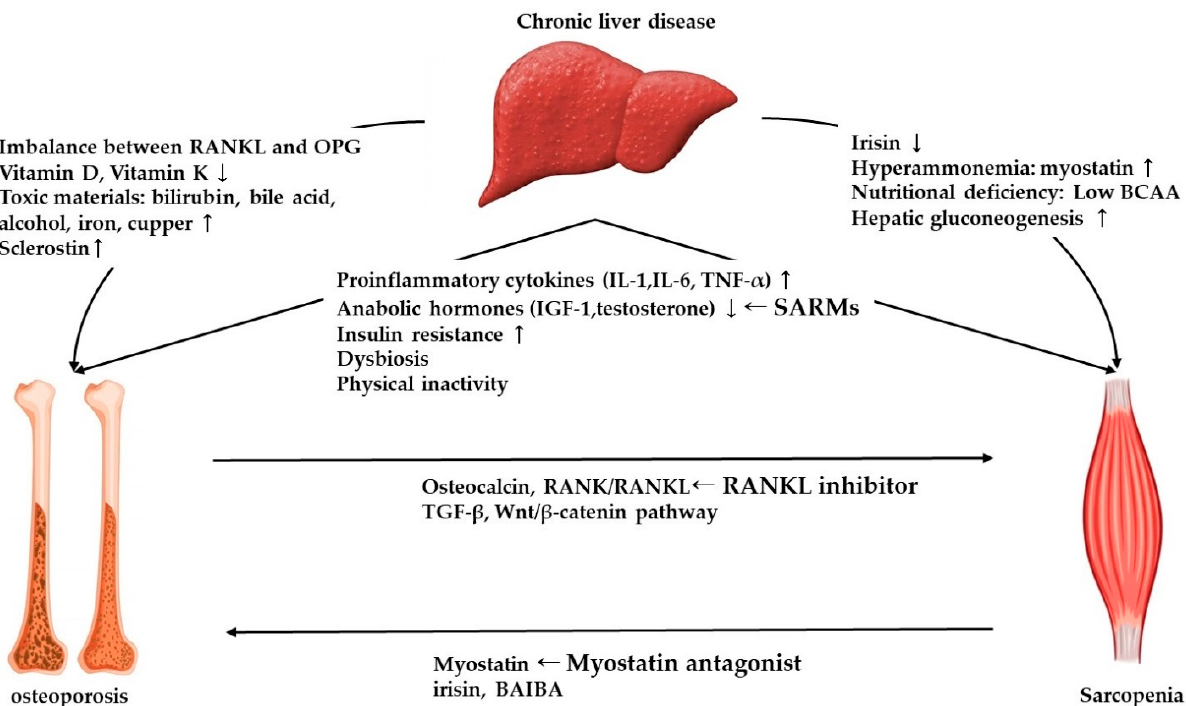
Figure 1. Overview of mechanism of osteosarcopenia in chronic liver disease and potential therapeutic strategies. RANKL, receptor-activator of nuclear factor kappa ligand; OPG, osteoprotegerin; IGF-1, Insulin-like growth factor-1; BCAA, branched chain amino acids; BAIBA, beta-aminoisobutyric acid; SARM, Selective androgen receptor modulator.